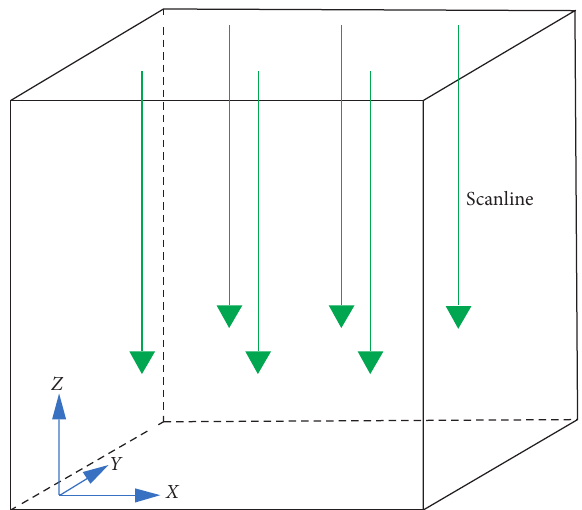
Figure 7: Schematic of vertical scanline